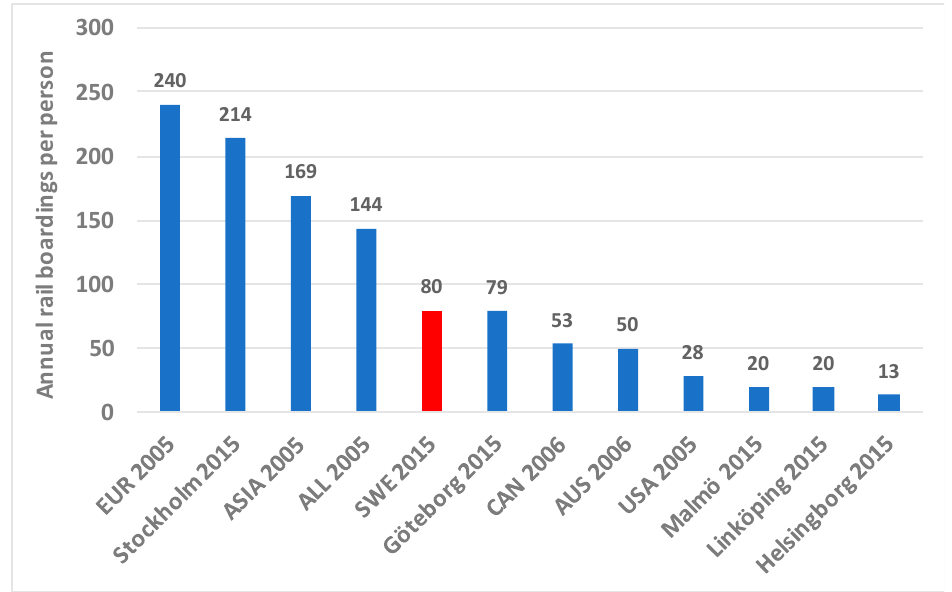
Figure 9. Annual rail boardings (tram, light rail, metro, and suburban rail) per person in five Swedish cities (2015) compared to a sample of global cities (2005–2006).